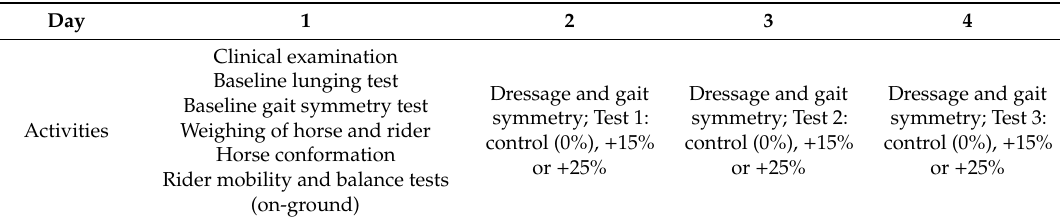
Table 2. Overview of Tests and Test Days.